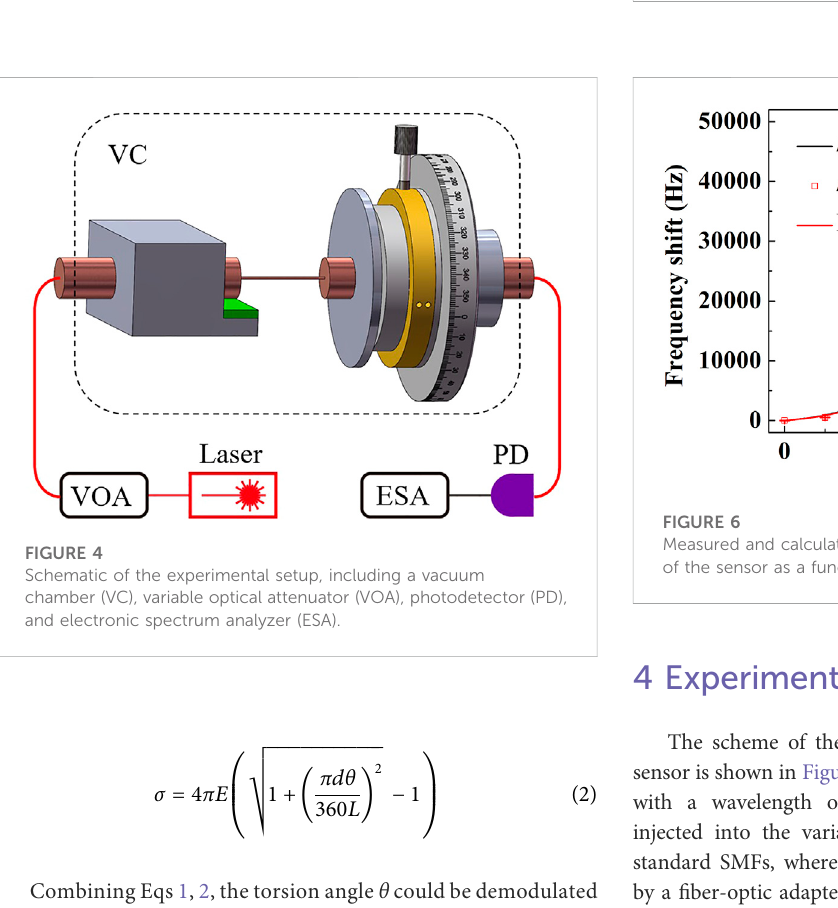
FIGURE 5 Normalized mechanical power spectrum of the fundamental mode for the sensor. Inset mode shape of the fundamental mode.